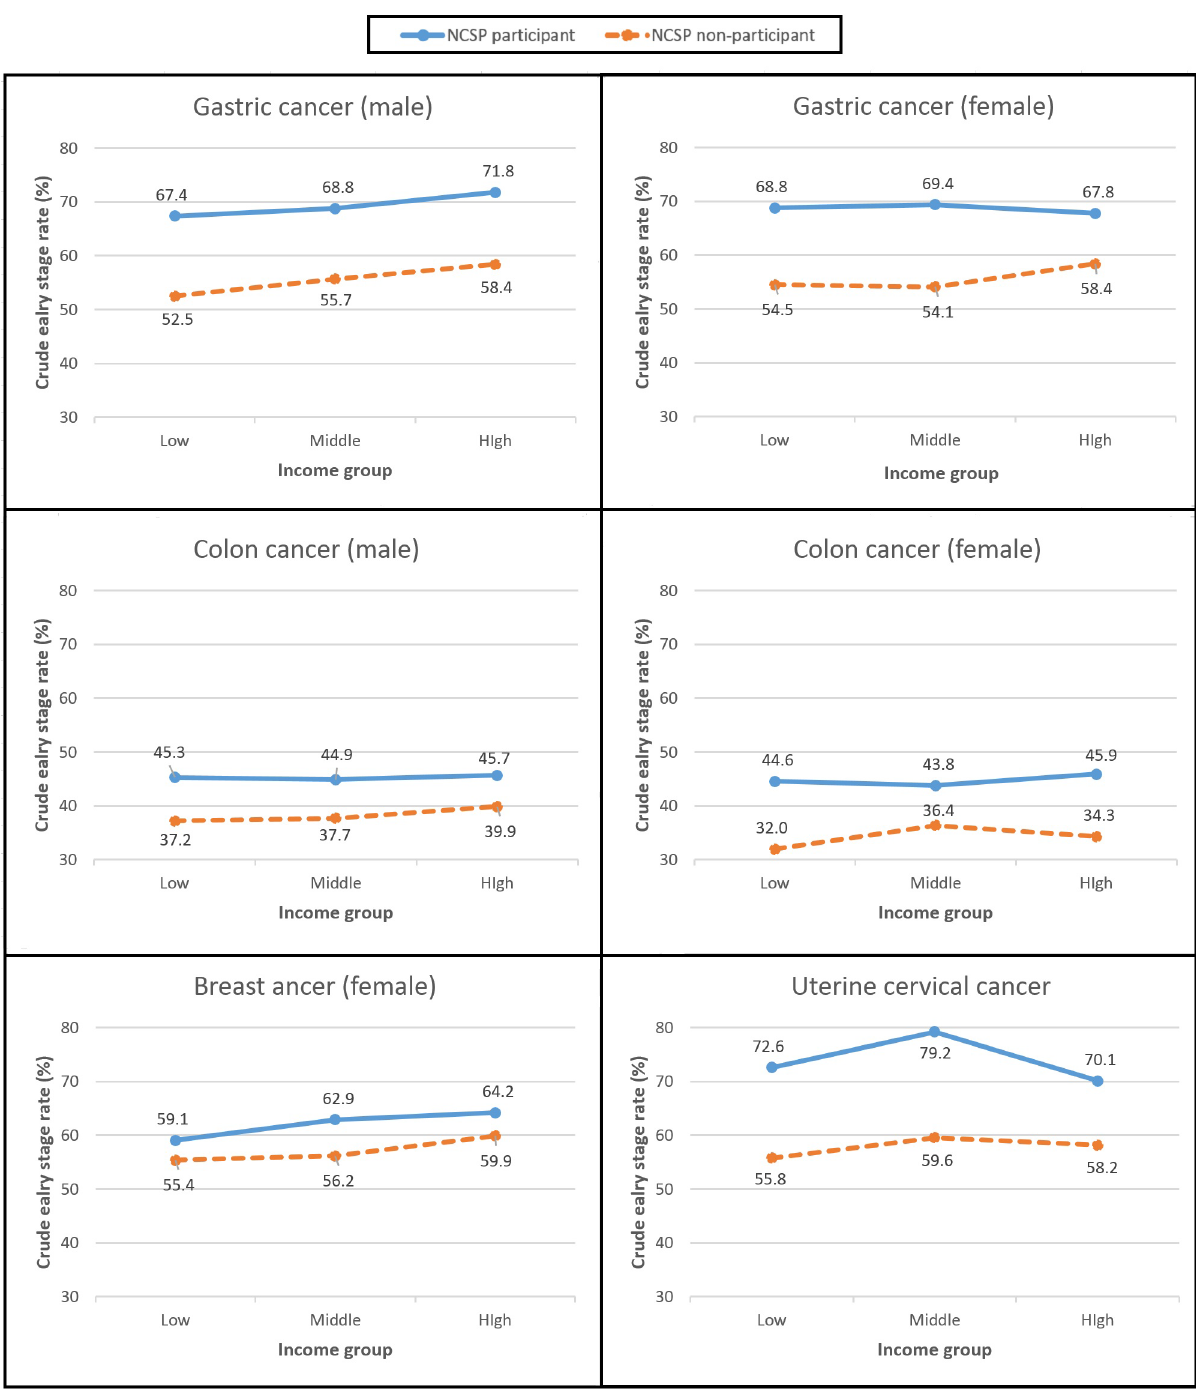
Fig 1. Crude early stage rate by income level according to National Cancer Screening Program participation.